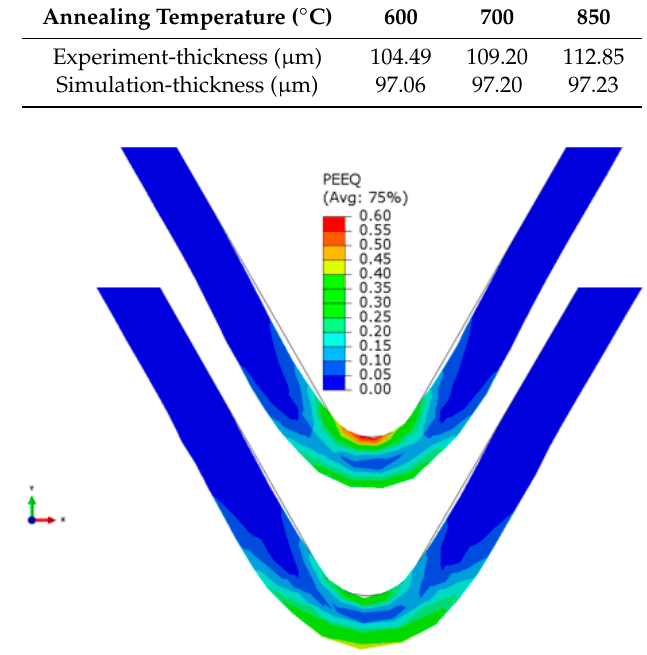
Figure 13. Equivalent strain distribution in bending by the finite element model.